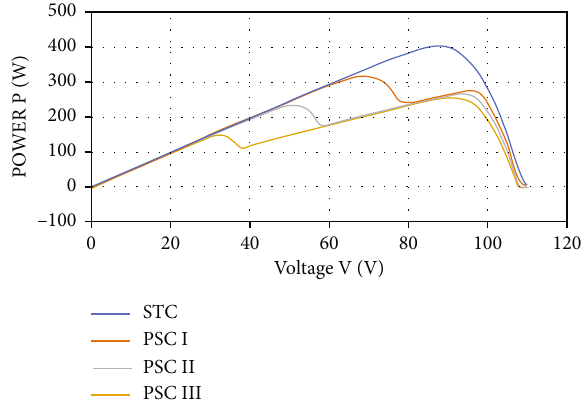
Figure 14: PV curve under